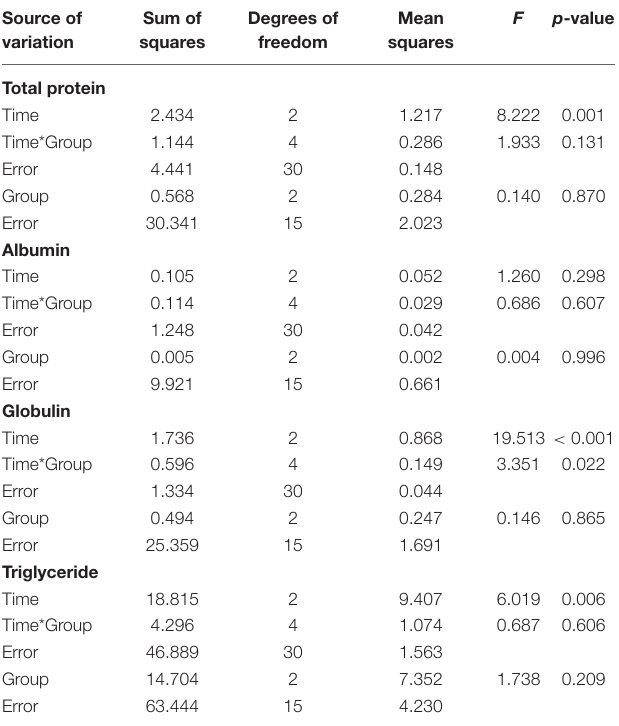
TABLE 5 | Interaction effect of time and group on total protein, albumin, globulin, and triglyceride concentration by repeated measures ANOVA. F p Source of Sum of Degrees of Mean variation squares freedom squares